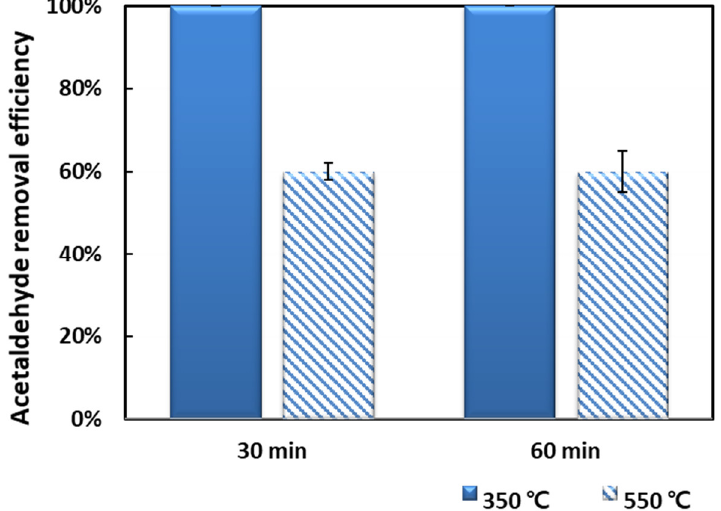
Figure 6. The effect of calcination temperature for the 10 wt.% Mn/NZ on the acetaldehyde oxidation. Relative Humidity: 60%, The amount of catalysts: 5 g.